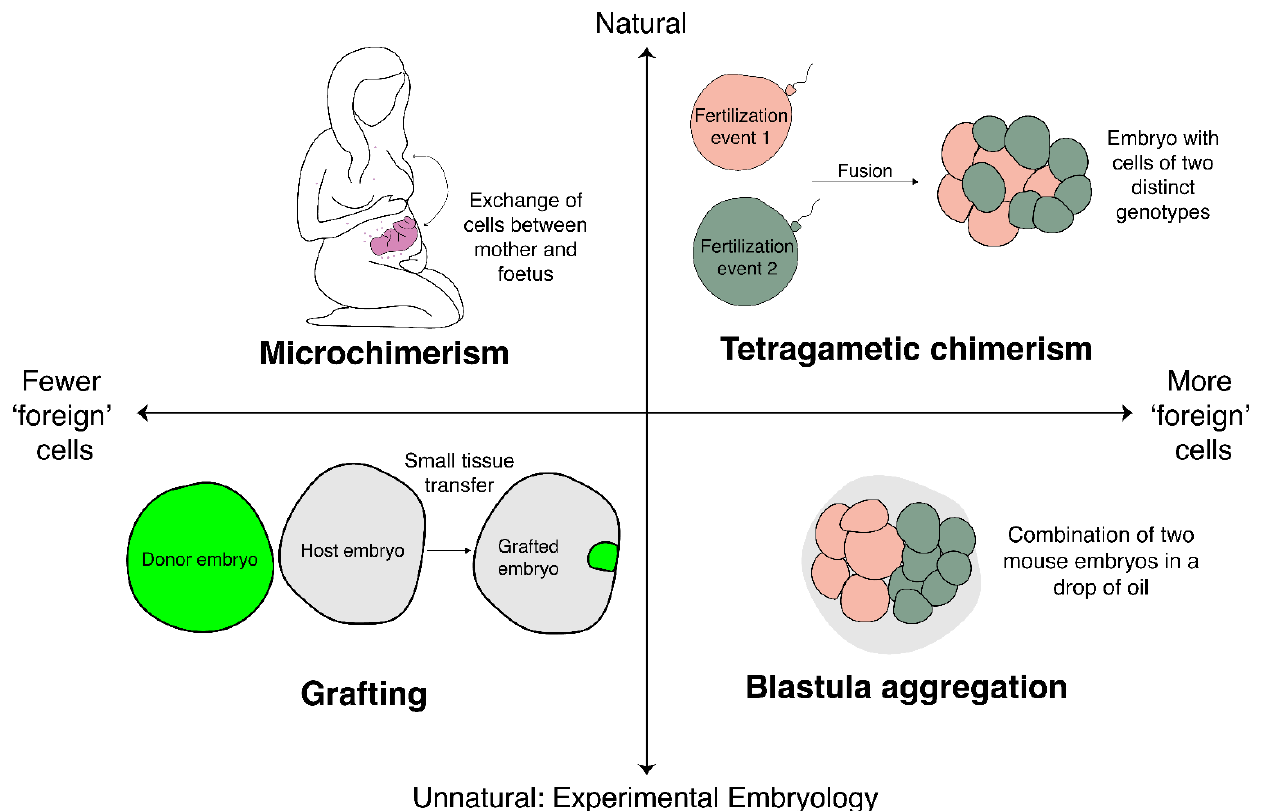
Figure 1. A spectrum of chimeras. This diagram conceptualises examples of chimeras discussed across two axes: degree of naturality (i.e., naturally occurring or produced by experimental manipulation), and the proportion of foreign cells relative to total cell number. Naturally occurring chimeras include microchimeras ( top left ) and tetragametic chimeras ( top right ). Experimentally produced chimeras include grafted embryos ( bottom left ) and blastula aggregation experiments ( bottom right ). See text for